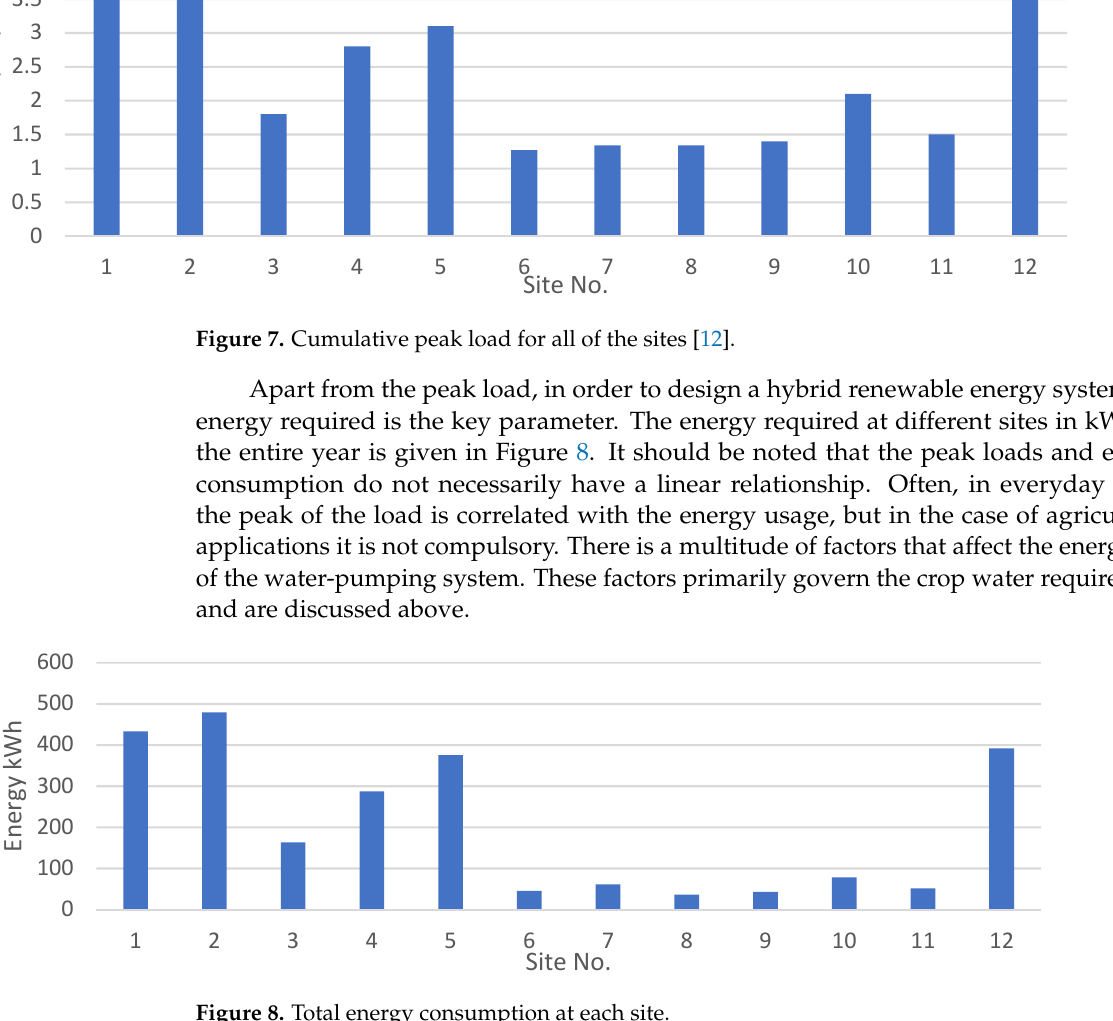
Figure 6. Peak load for each crop at each site.